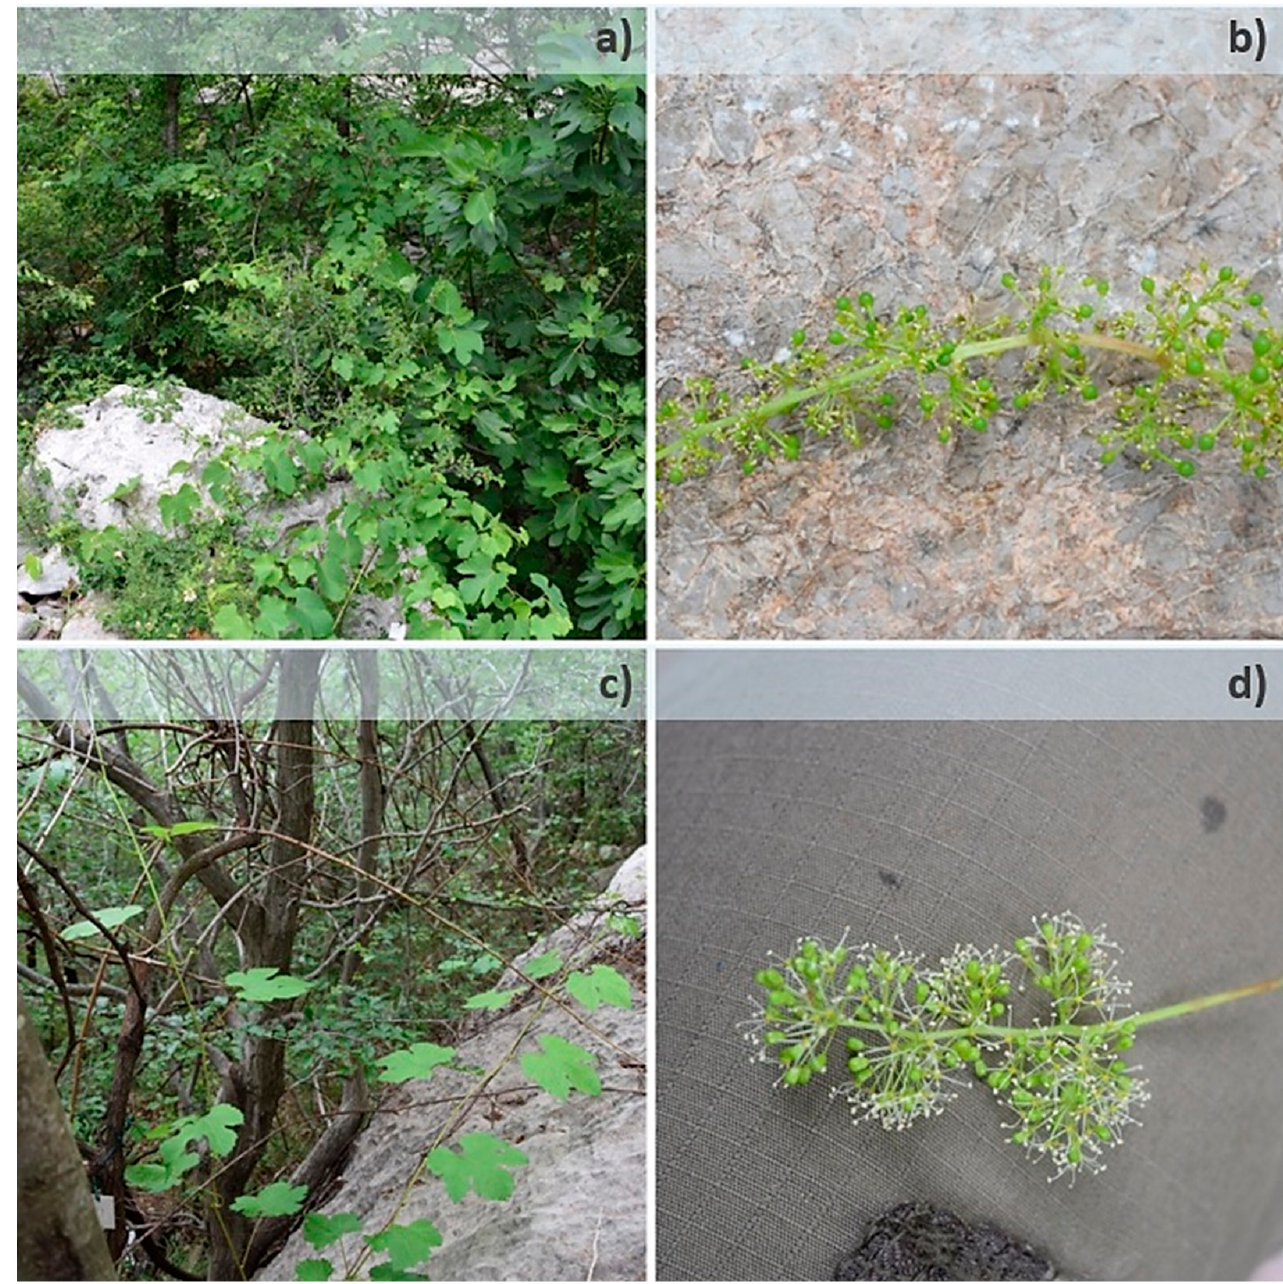
Figure 1. Two V. sylvestris individuals from the same population as an example of difference in flower morphology: female Pak10 ( a , b ) and male Pak21 ( c , d ). Each individual captured in natural habitat with closer view to its flower type .